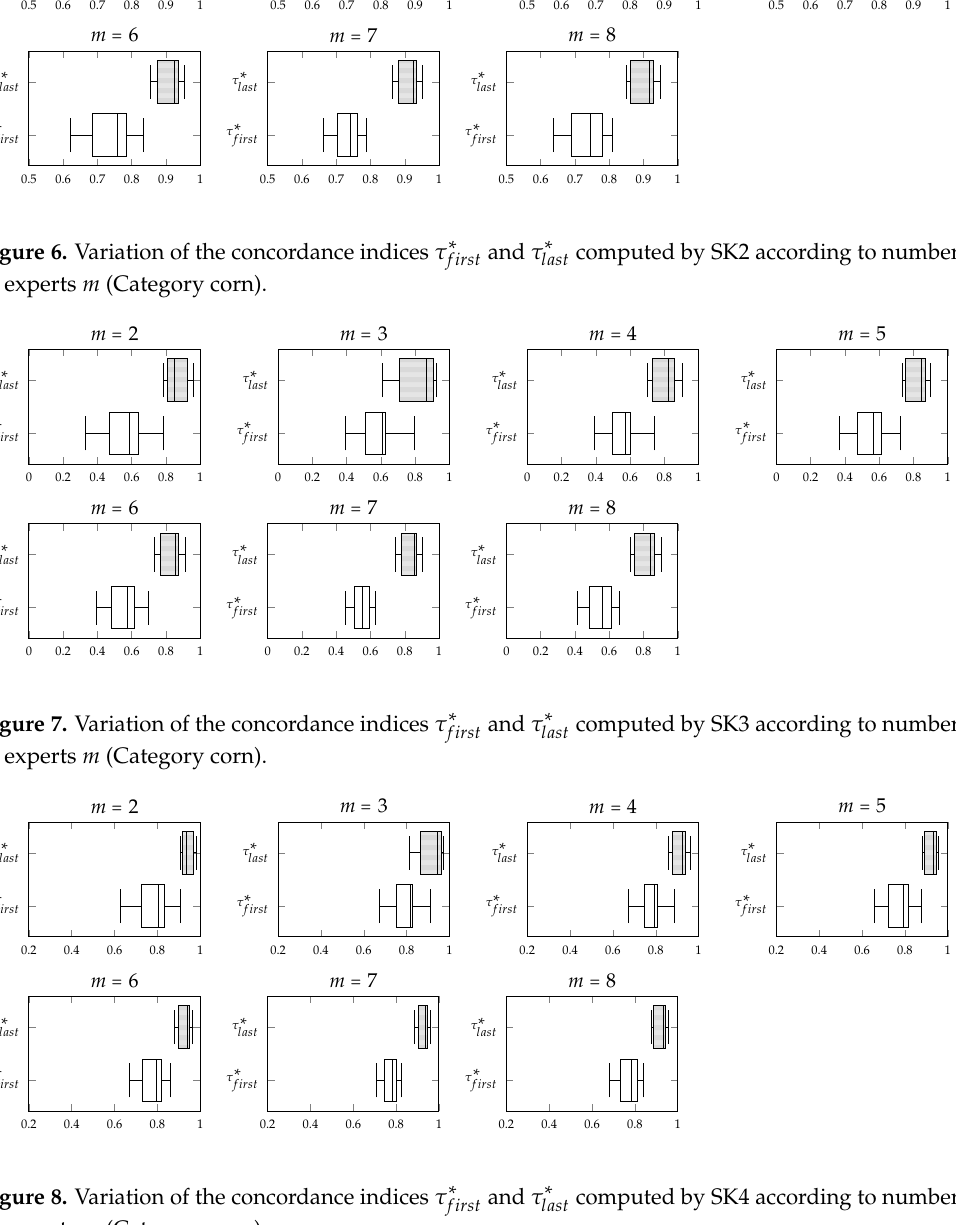
and τ ∗ computed by SK4 according to number first last